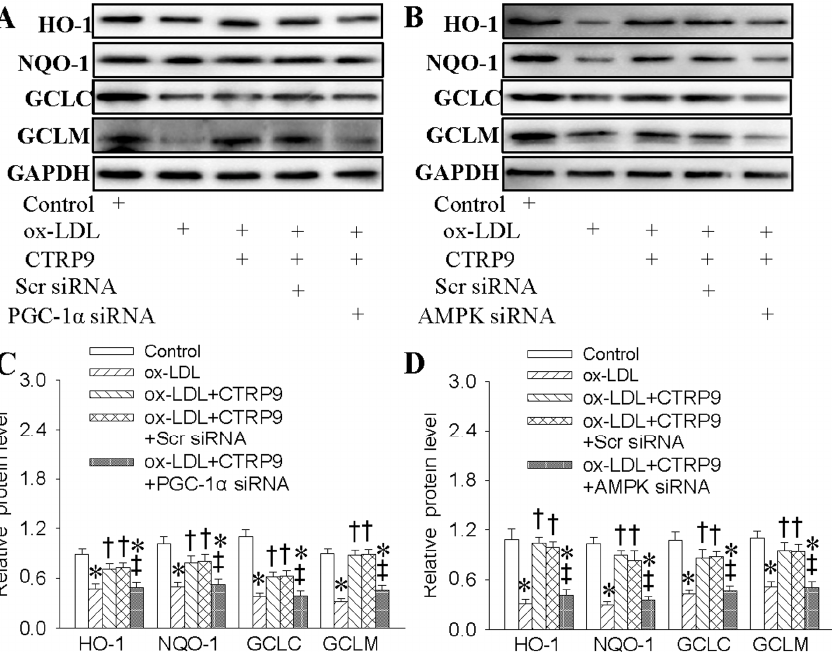
Figure 6. Both AMPK and PGC1- α participated in CTRP9-upregulated antioxidant enzymes in the context of ox-LDL. HUVECs were transfected with Scrambled (Scr) siRNA, PGC-1 α siRNA or AMPK siRNA for 24 h, and then incubated with CTRP9 (3 µ g/mL) for 6 h followed by ox-LDL (100 µ g/mL) challenge for 24 h. ( A , C ) Effects of PGC-1 α siRNA on the antioxidant enzymes expressions in HUVECs response to ox-LDL. ( B , D ) Effects of AMPK siRNA on the antioxidant enzymes expressions in HUVECs response to ox-LDL. Values are mean ± SE. * p < 0.05 vs. 0 h, Control, † p < 0.05 vs. ox-LDL, ‡ p < 0.05 vs. ox-LDL + CTRP9 or ox-LDL+ CTRP9 + Scr siRNA. n = 4 for each group.